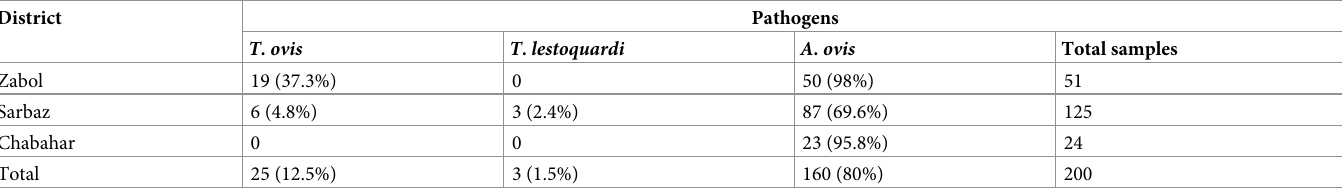
Table 2. Pathogens identified in different districts in Sistan and Baluchestan province.